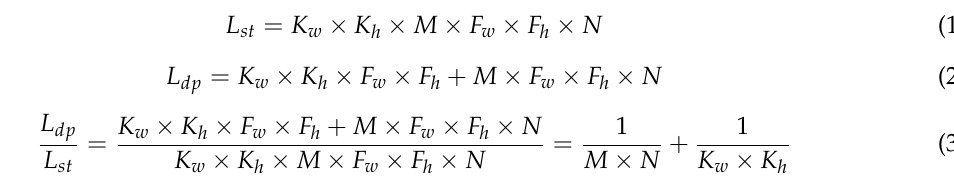
Figure 4. Left column denotes the structure of standard convolution, and the right column represents the structure of depthwise-pointwise convolution. The body architecture of the base network is shown in Table 1. All of the layers are followed by a batch norm and ReLU nonlinearity. Figure 4 demonstrates a layer with regular convolutions, batch norm, scale and ReLU nonlinearity to the factorized layer with depthwise convolution, and pointwise